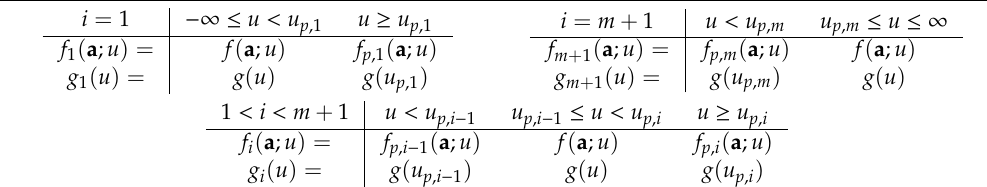
Table 1. Functions g i ( u ) and f i ( a ; u ) for i = 1, i = m + 1 and 1 < i < m +